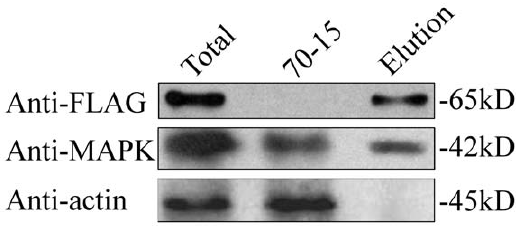
Figure 1. MoSfl1 co-immunoprecipitates with Pmk1. Western blots of total proteins (Total) and proteins eluted from the anti-FLAG M2 beads (Elution) of transformant GSF7 that expressed the MoSFL1 - 3 6 FLAG construct were detected with the anti-FLAG and anti-MAPK antibodies. Total proteins isolated from the wild-type strain (70-15) and detection with the anti-actin antibody was included as the